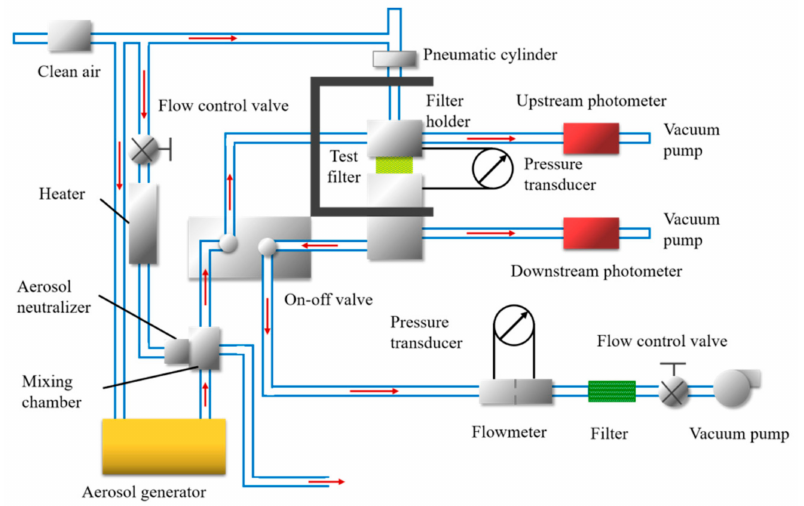
Figure 4. Schematic diagram of the experimental device used to test the filtration